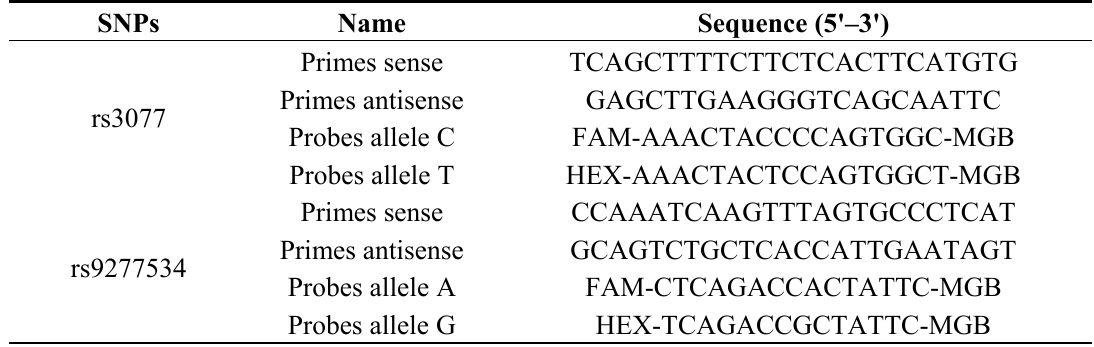
Table 7. The information on primers and allele-specific fluorogenic probes for the two single nucleotide polymorphisms